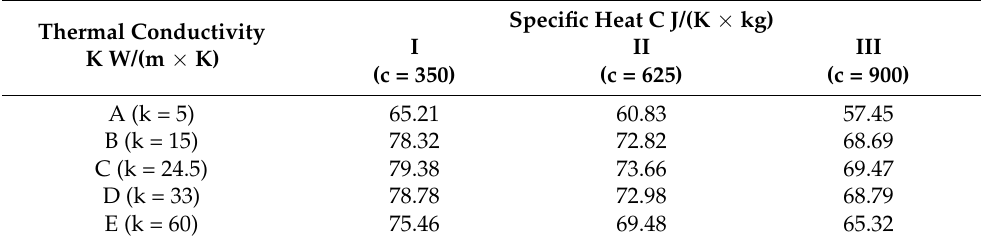
Table 6. Summary of the influence of the thermal conductivity and specific heat factor on the maximum temperature of the aluminum